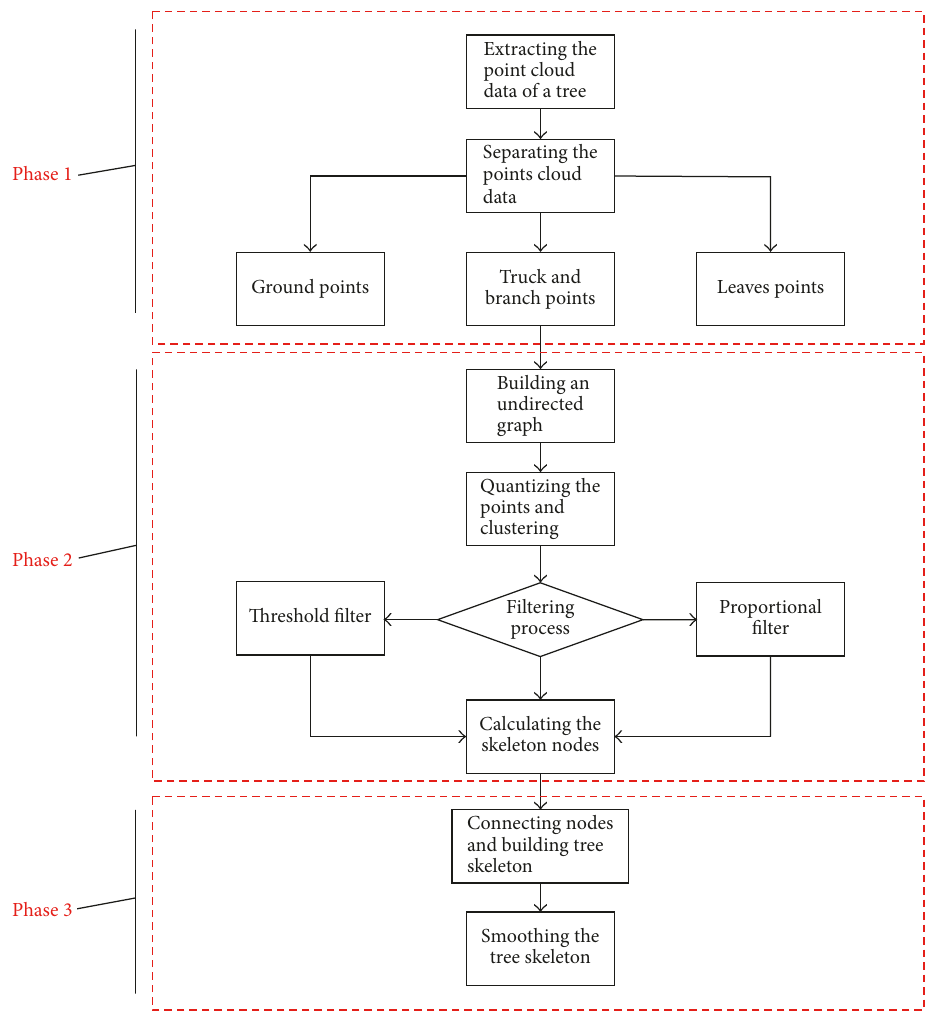
Figure 1: Flow chart of skeleton generation